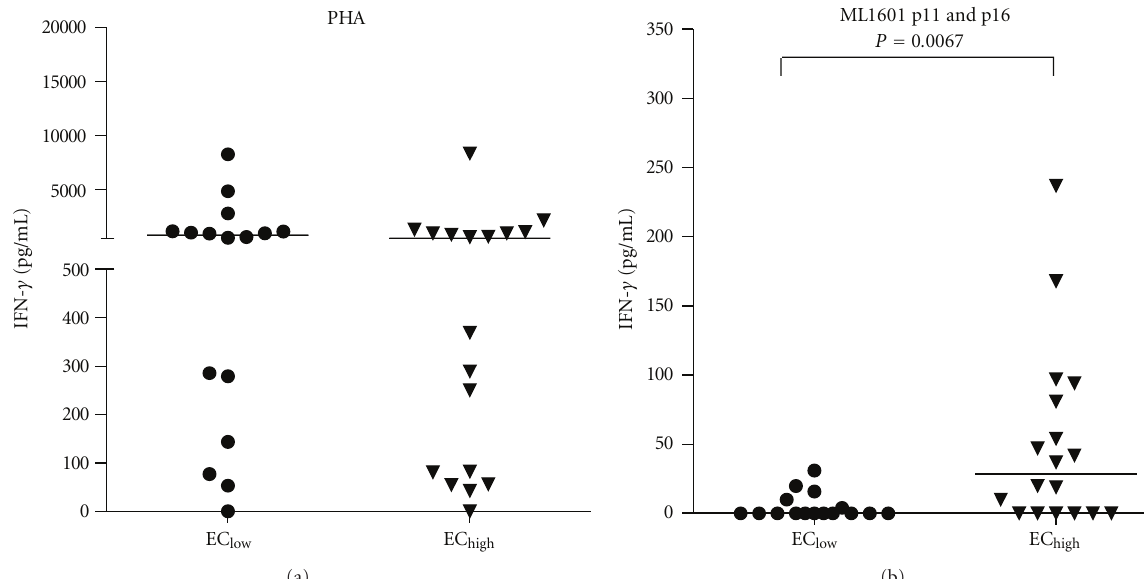
Figure 4: IFN- γ production in response to the positive control PHA (a) or a mix of ML1601c peptides no. 11 and no. 16 (b) measured after 24h culture of undiluted whole blood derived from 34 Ethiopian healthy controls (ECs) derived from areas with low endemicity for leprosy (EC low : n = 16) or from areas highly endemic for leprosy (EC high : n =